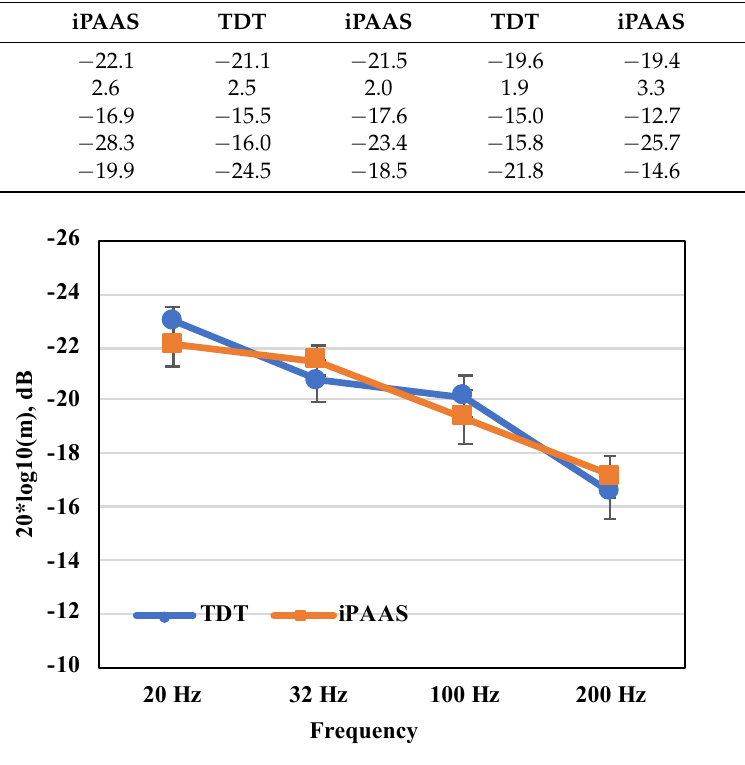
Figure 5. AMD thresholds as a function of modulation frequency. AMD thresholds are shown in filled squares and in filled diamonds for the laboratory-based system (TDT) and iPAAS system, respectively. The error bars represent the standard error of the mean.